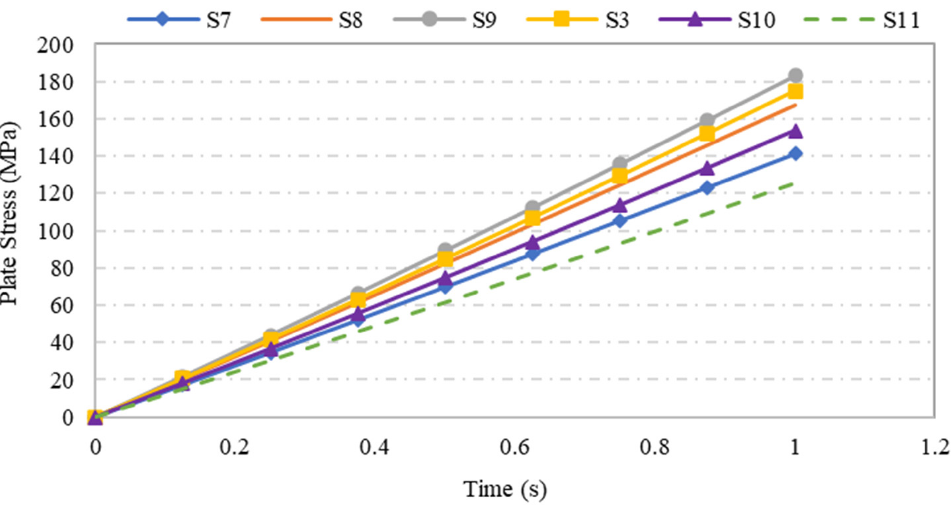
Figure 14. Variation in maximum stress of steel plate specimens with varying opening aspect ratios over